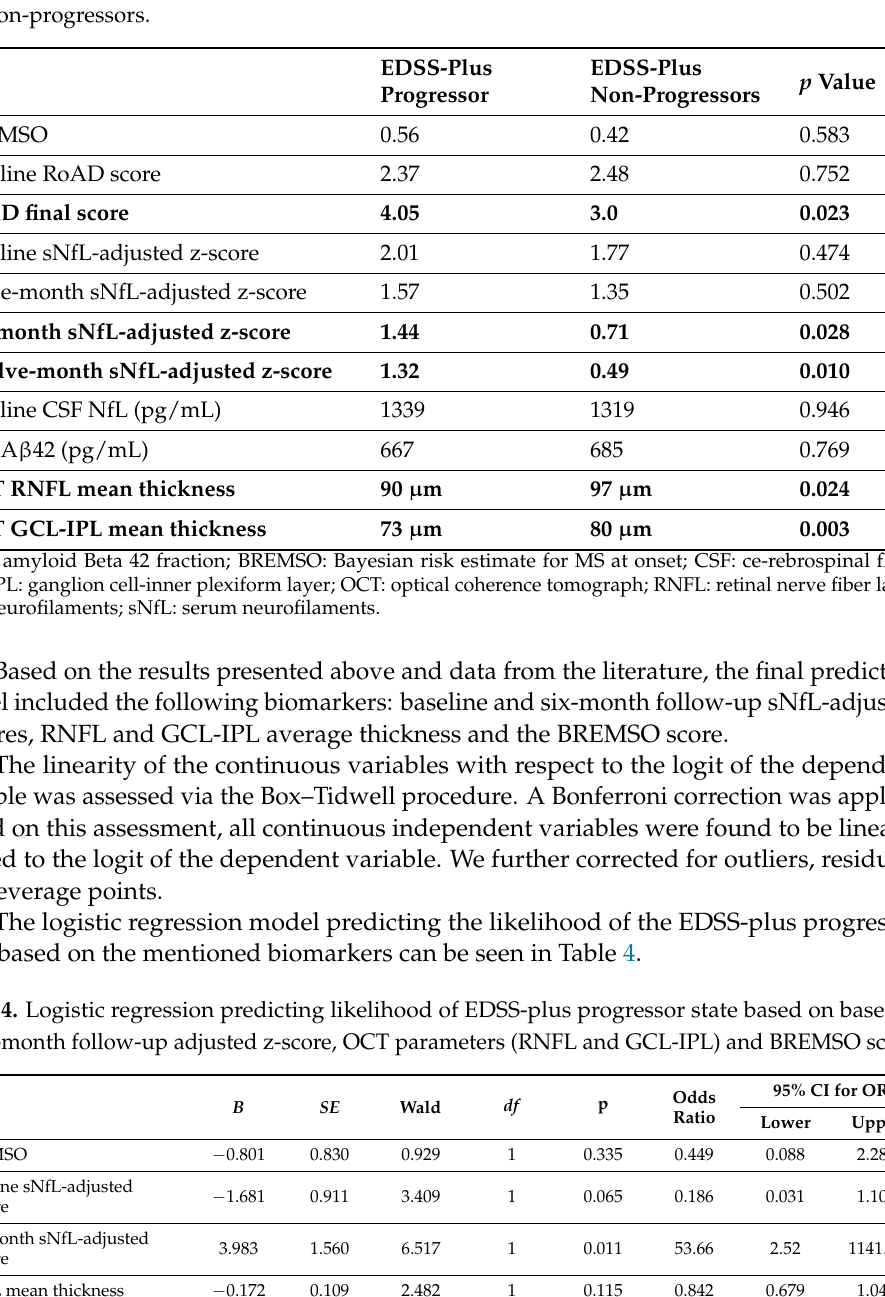
Table 3. Biomarkers and clinical prediction score differences between the EDSS-plus progressors and non-progressors.